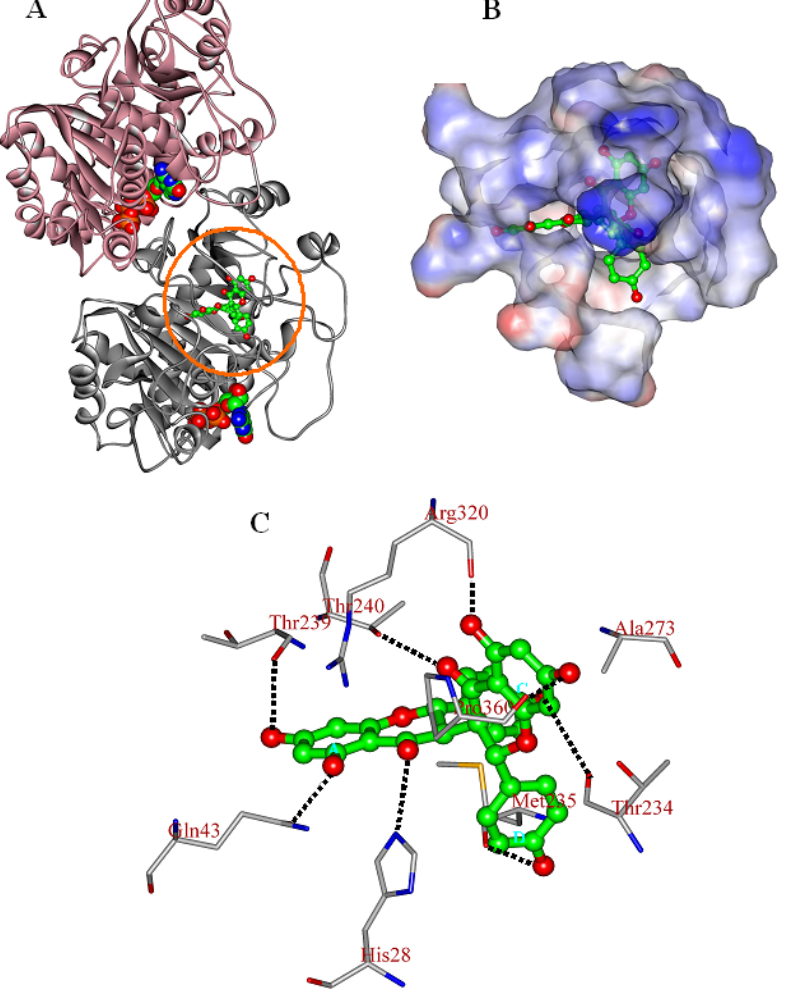
Figure 4. The propeller structure ( A ), the active site ( B ), and key residues in the active site of the chamaejasmine-TB complex. The tubulin (TB) protein is in ribbon. The gold ring shows the active site. The Connolly surfaces of the TB active site (in property) are created using the InsightII 2005scripts. Chamaejasmine is represented by the ball and stick model.